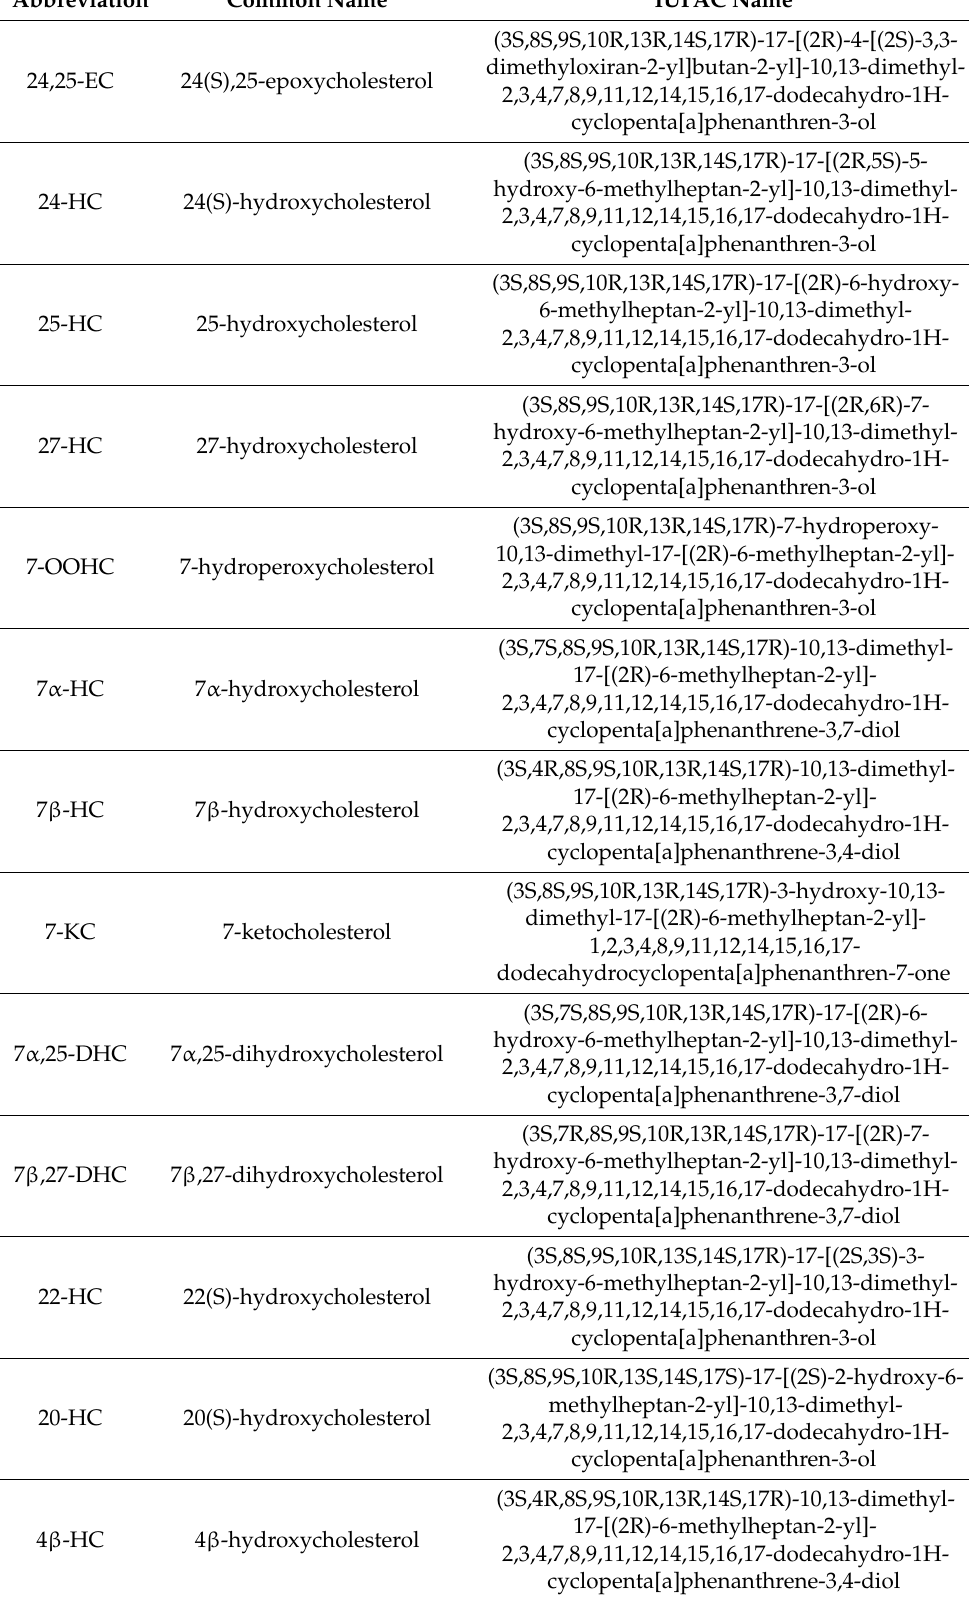
Table 1. Common names of the main oxysterols and their chemical